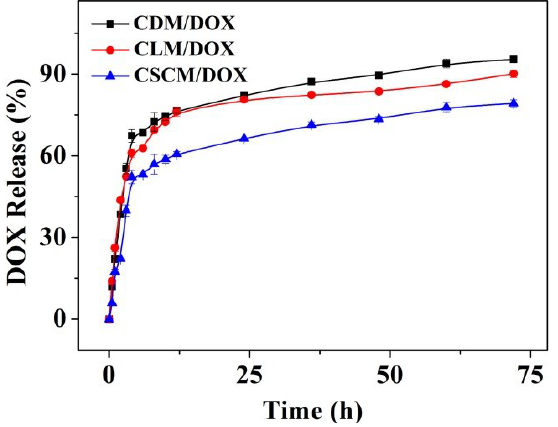
Figure 3. Release behaviors of CDM/DOX, CLM/DOX, and CSCM/DOX in PBS at pH 7.4, 37 °C. Each set of data was presented as mean ± SD ( n =